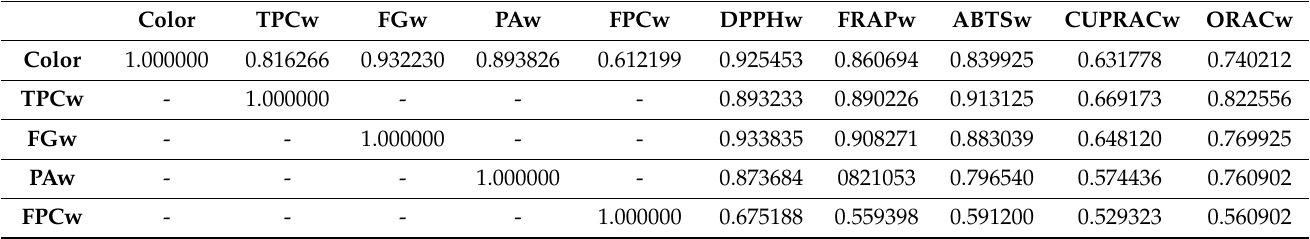
Table 4. Correlation analysis of methanol wort